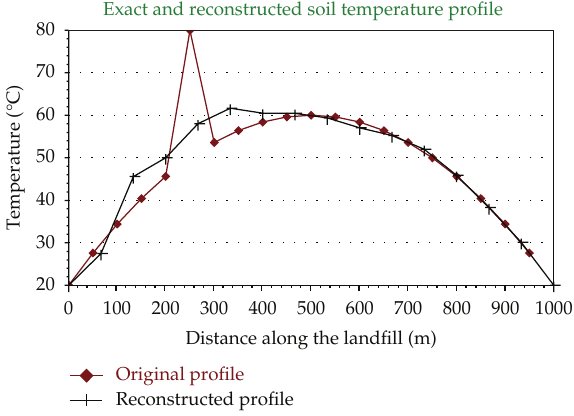
Figure 9: Fifteen intervals—Tikhonov’s regularisation factor-assumed heat transfer coe ffi cient equal to 110% of the value used to generate the simulated